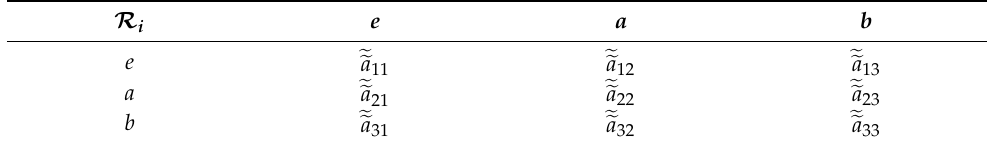
Table 7. The values of the cubic relations R i